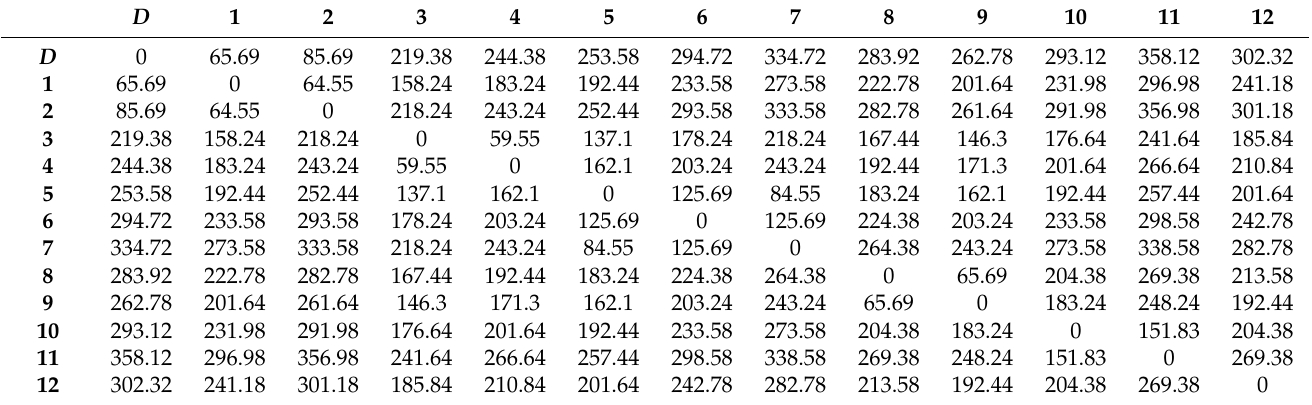
Table 5. Travel time matrix estimation with new travel time calculator (unit: s).